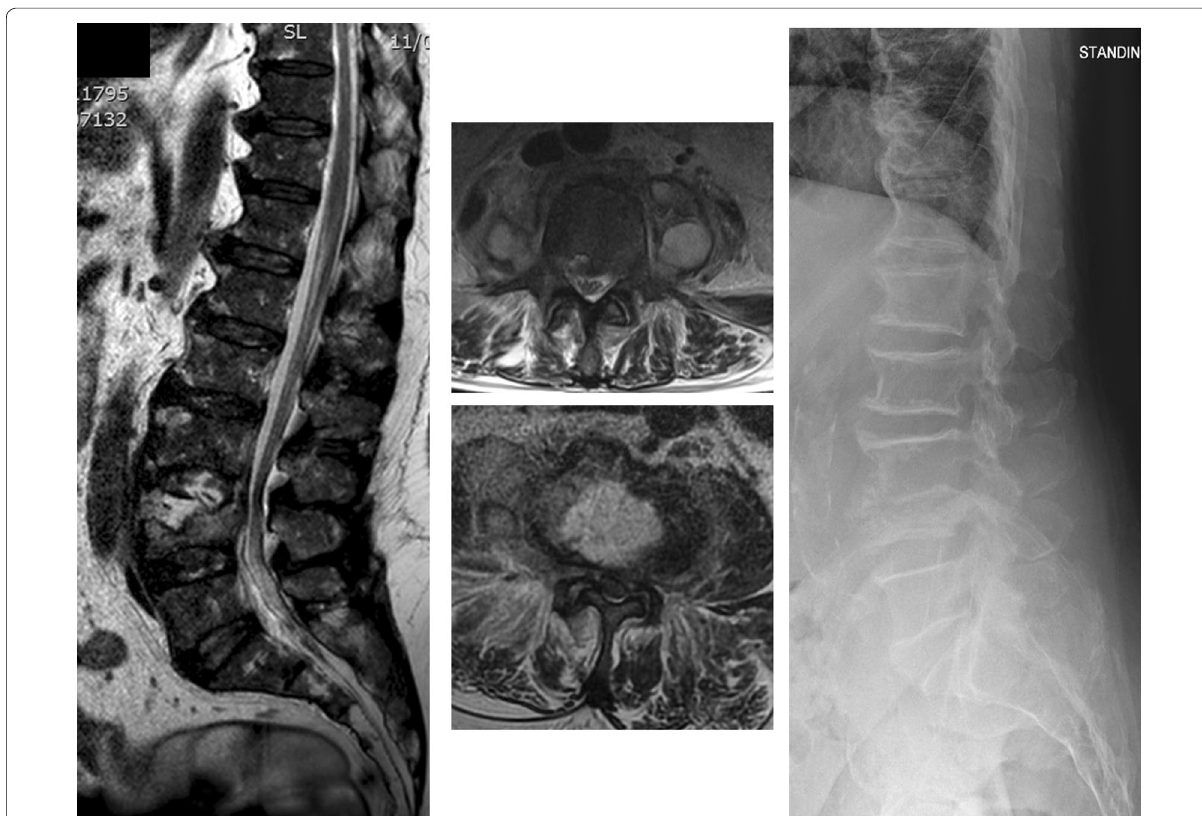
Fig. 4 A 75‑year‑old patient with pyogenic spondylodiscitis at L3/L4. S. aureus had been identified by blood cultures 10 days earlier and IV antibiotic therapy was started soon afterwards. After 10 days of IV therapy, the patient was still complaining of significant pain with incomplete improvement of the inflammatory markers (CPR 135 mg/L). (Left panel) MRI sagittal view of the involved disc space; (middle panel) axial view at the level of the L3/L4 disc space and the L4 vertebral body showing a significant disc abscess and bilateral psoas abscesses. (Right panel) standing X‑ray of the lumbar spine showing resolution of the infection and fusion of the involved segment 8 months after the end of